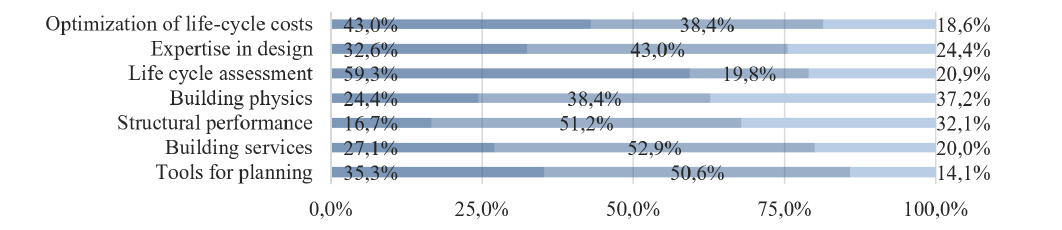
Figure 3. Knowledge gaps (grouped by rated values 1 to 2, 3 to 4 and 5 to 6, where 1 means high gap of knowledge and 6 no gap at all).